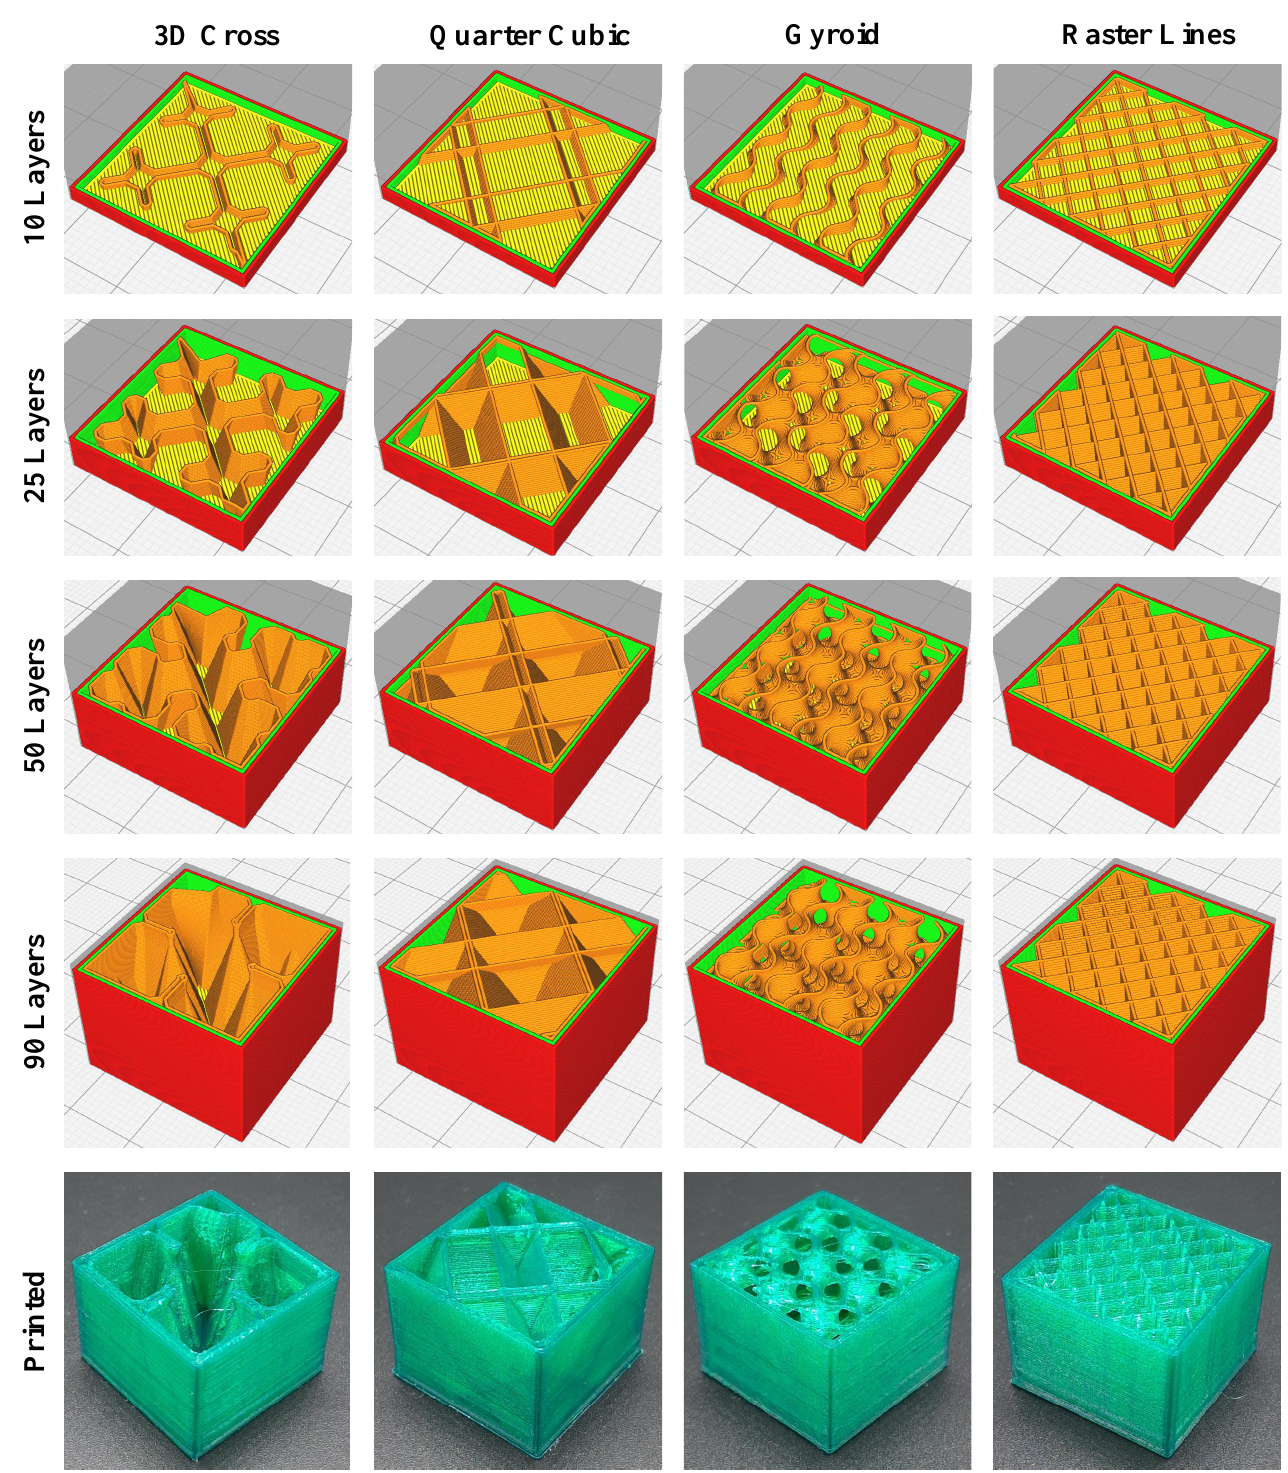
Figure 19. Results of Case Study